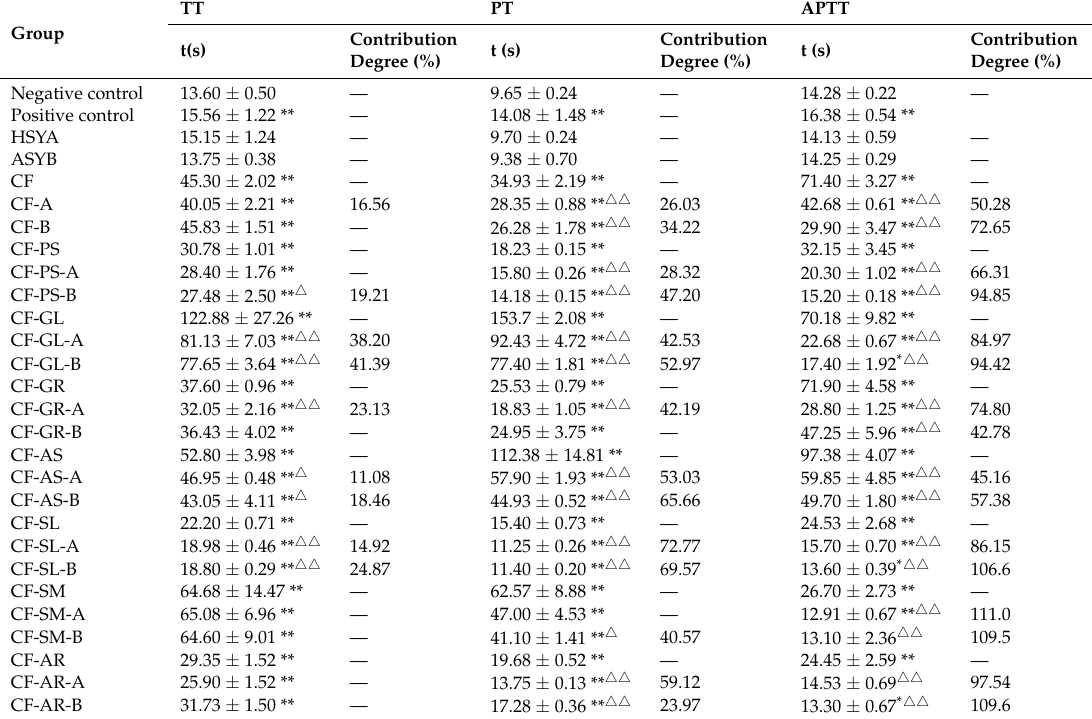
Table 3. Samples before and after knocking out the target component and knock-out constituents in safflower series of herb pairs on TT, PT, and APTT (mean ± SD, n = 4).